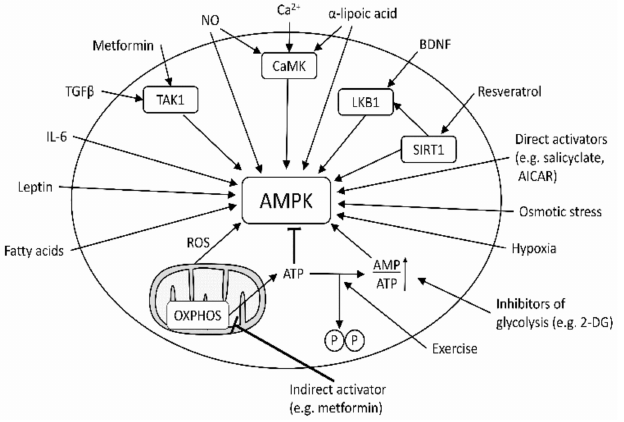
Figure 5. Activation pathways of